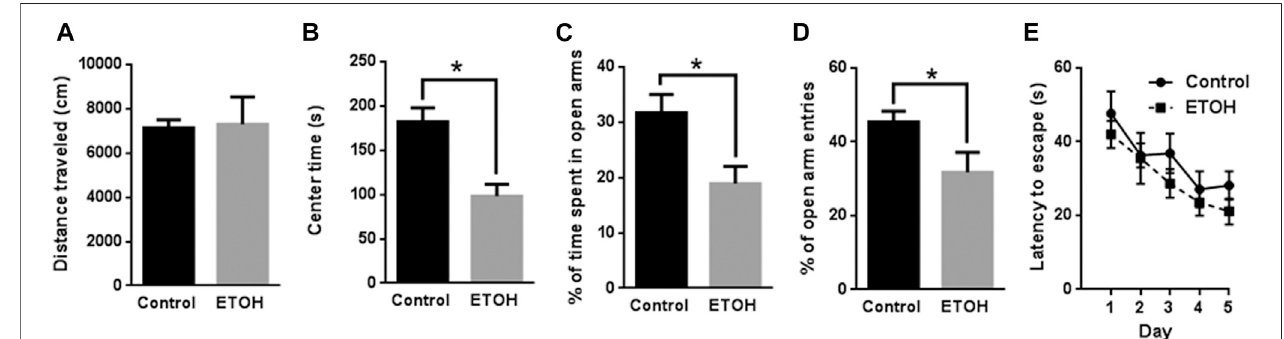
FIGURE 1 | Effects of 7 months of voluntary alcohol drinking on anxiety-like behavior in female cHAP mice. After that, mice were subjected to Open Field (OF) test (A,B) , Elevated Plus Maze (EPM) test (C,D) , and Morris Water Maze (MWM) test (E) . The total distance traveled (A) and the time spent in the center (B) in OF was measuredand presented asthemean ± SEM(n (cid:2) 7) ineach group. Thepercentage oftime spentin openarms (C) and percentage ofentrynumbers intoopen arms (D) in EPM were quanti fi ed and presented the mean ± SEM (n (cid:2) 7). (E) The spatial learning and memory were evaluated by MWM. The total latency escape time was measured and presented as the mean ± SEM (n (cid:2) 7). Unpaired student t-test was used to assess the differencebetween control and alcohol-exposed group. * p < 0.05 denotes a statistically signi fi cant difference from the control group.